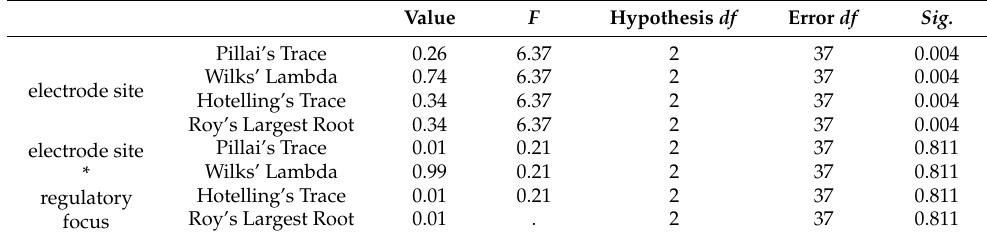
Table 4. Multivariate tests of N1 amplitude (regulatory focus).